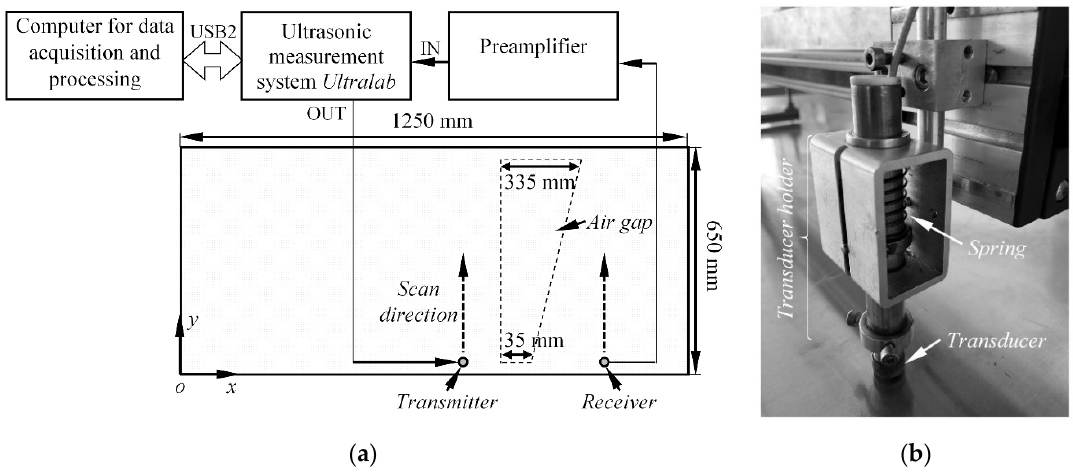
Figure 10. Illustration of experimental setup used to validate the predictions ( a ), spring type adjusters used in the experiment to ensure reliable acoustic contact ( b